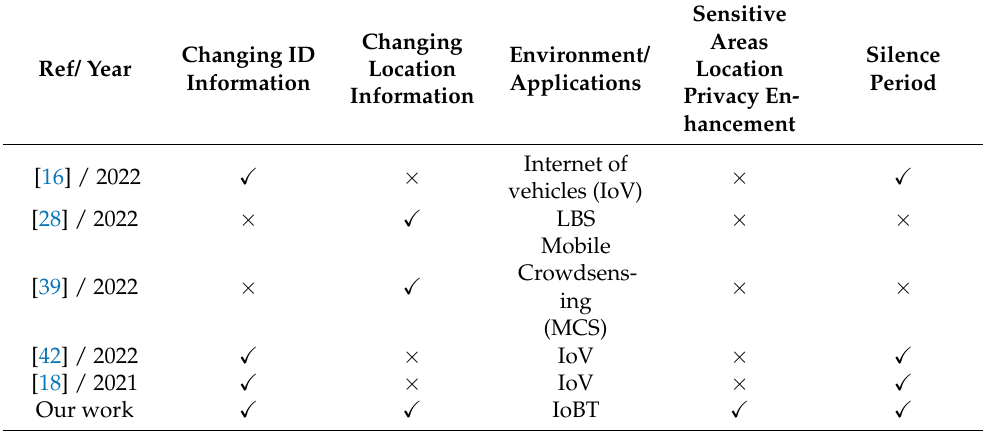
Table 1. The comparison of our work to recent deception-based related